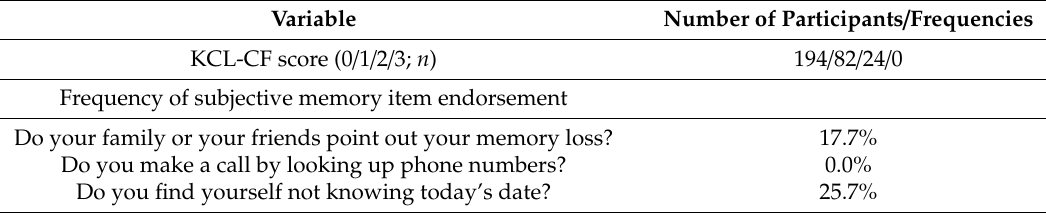
Table 1. KCL-CF scores and frequency data for SCD items.